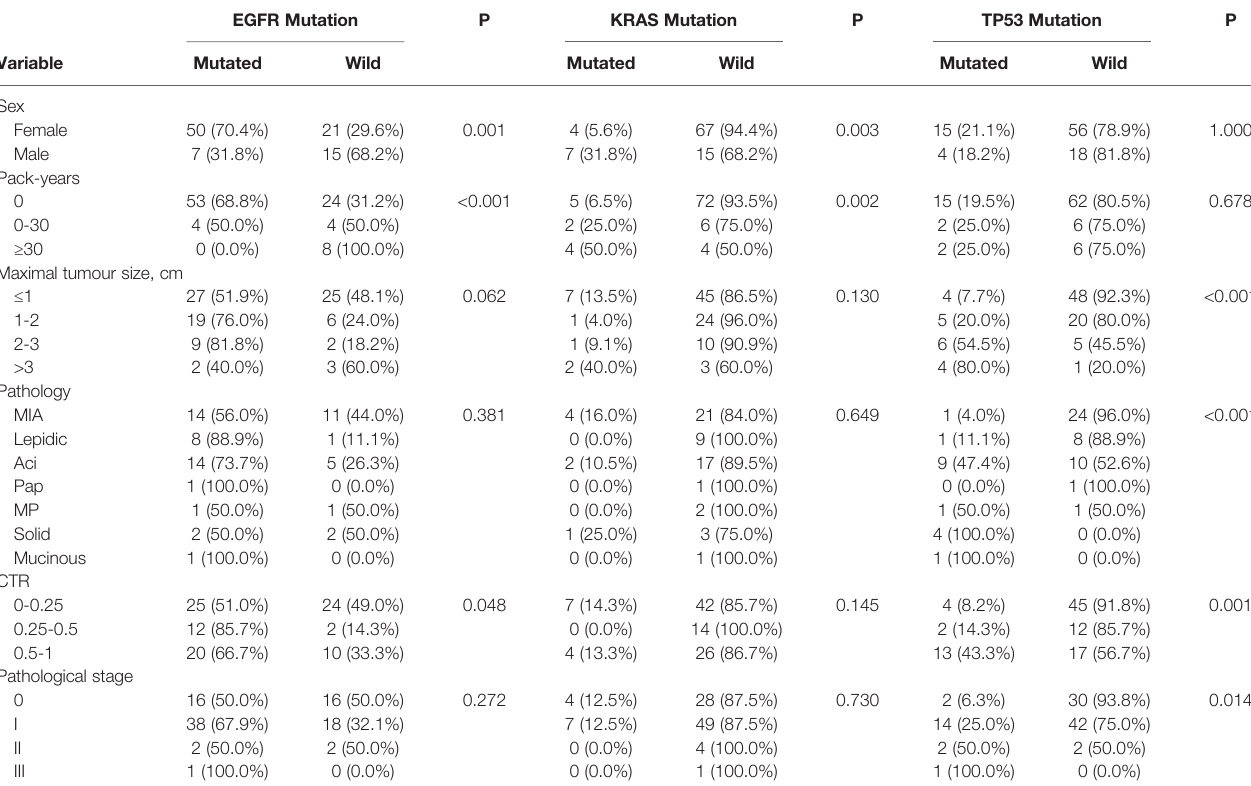
TABLE 2 | Frequency of EGFR, KRAS and TP53 mutations in relation to clinicopathological and imaging characteristics of 93 sMPLA.